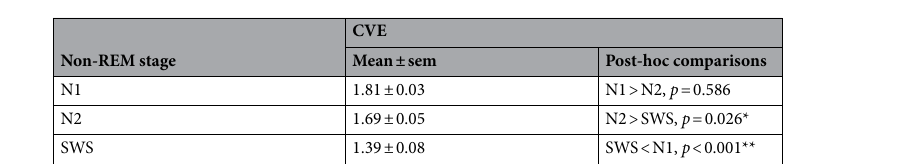
Figure 4. Time-Course of δ-Power of the non-REM Sleep EEG & Relative Occurrence of δ-Power in Each non-REM stage. ( A ) The 30-min means ± SE of δ-power of the 9 participants are shown as a line graph and accumulated δ-power during non-REM is shown as a bar graph. *Represents a statistically significant difference between the control trial and exercise trial by post hoc comparisons using Bonferroni’s correction for multiple comparisons ( p < 0.05). ( B – D ) Relative occurrences of δ-power in N1 ( B ), N2 ( C ), and SWS ( D ) stages are shown. Inserted bar graphs in each panel represent mean δ-power in each non-REM stage. Black plots (filled black circle) and bars (filled black square) represent control trials, and red plots (filled red circle) and bars (filled red square) represent exercise trials. § Represents a statistically significant difference between control trial and exercise trial by a paired t-test ( § p < 0.05).